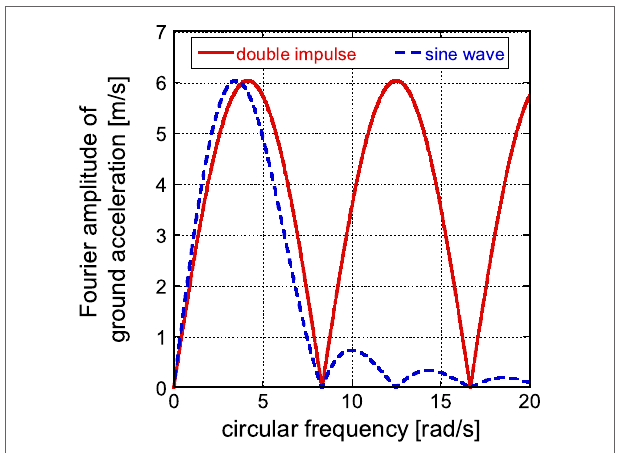
FigUre a2 | comparison of time histories of the first-story interstory drift and the first-story restoring force under the double impulse and the corresponding sinusoidal wave. (a) First-story interstory drift. (B) First-story restoring force.